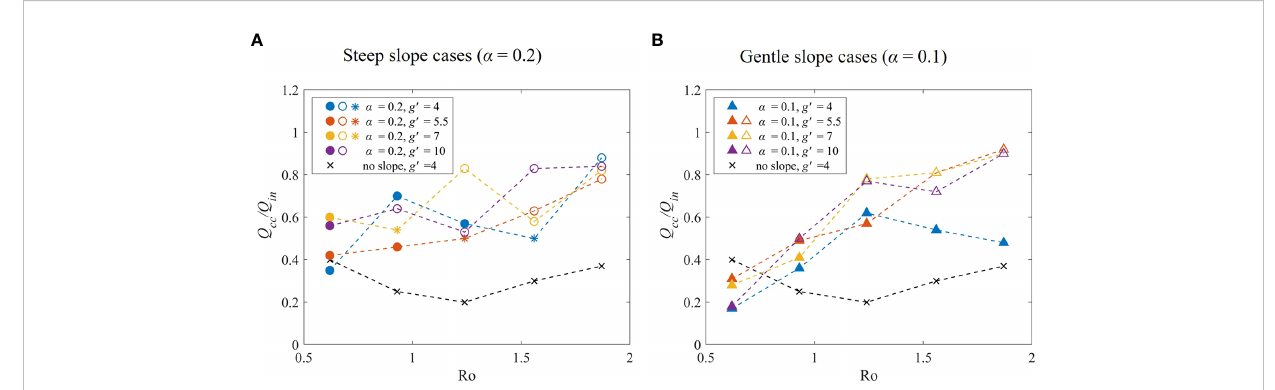
FIGURE 12 Normalized mean coastal current transport in stationary phase (8 – 9 T ). Circle and triangle symbols represent steep ( a = 0.2) and gentle slope ( a = 0.1) cases, respectively. The solid, asterisk and hollow symbols represent bottom-attached, transitional and surface-advected plumes, respectively. Black dash lines with cross symbols are the no-slope case for comparison. The dash line represents the trend of Q_cc/Q_in changing with